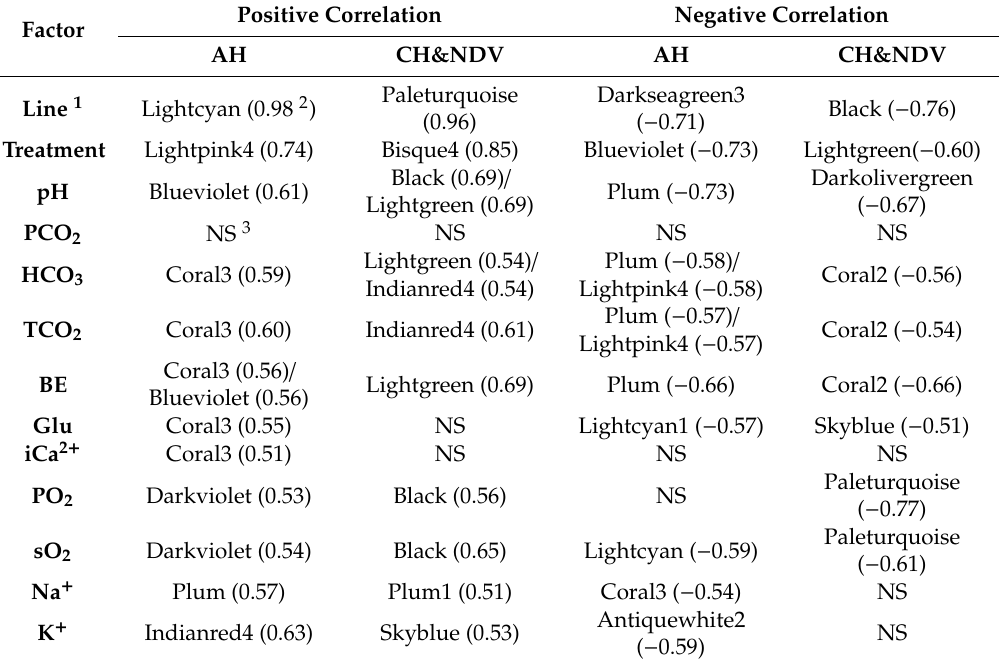
Table 3. Gene modules that were significantly associated with a factor (line or treatment or blood phenotype).